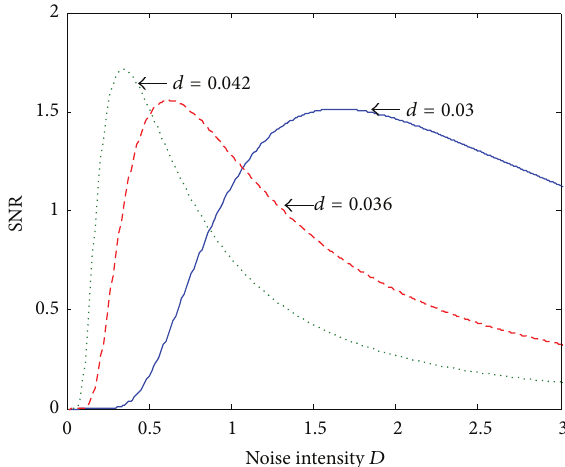
Figure 3: SNR versus noise intensity 𝐷 for different system parameters 𝑏 : 0.4, 0.45, and 0.5. Other parameters are 𝑐 = −0.31 and 𝑑 = 0.04 .